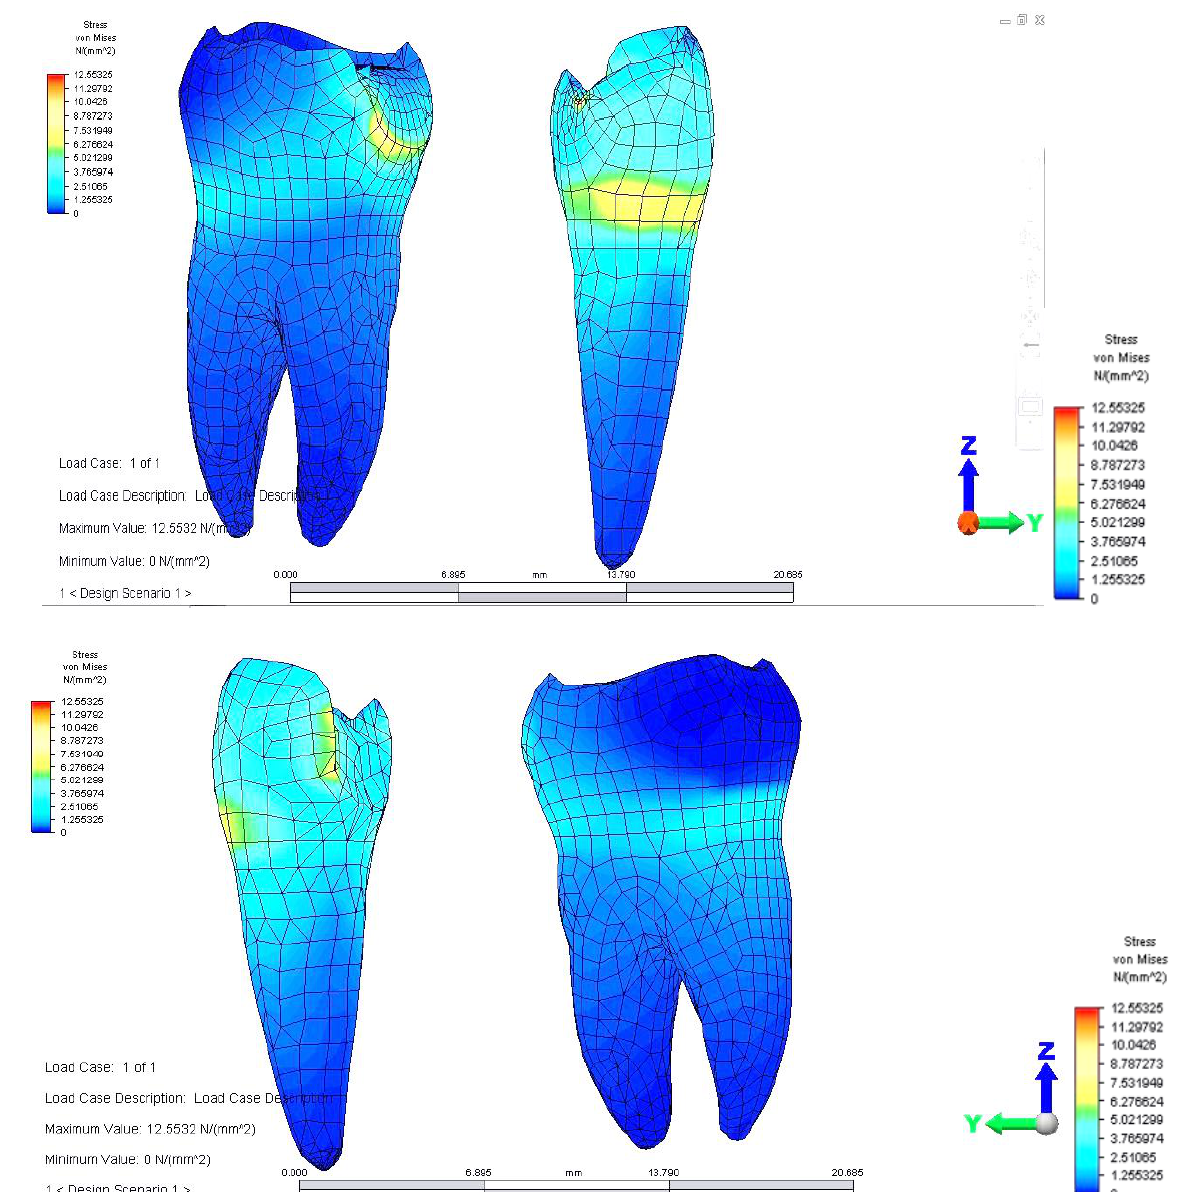
Figure 11. Tension distribution at abutments level in three directions: axonometric, right and left when the force is placed in the 3.4 area.